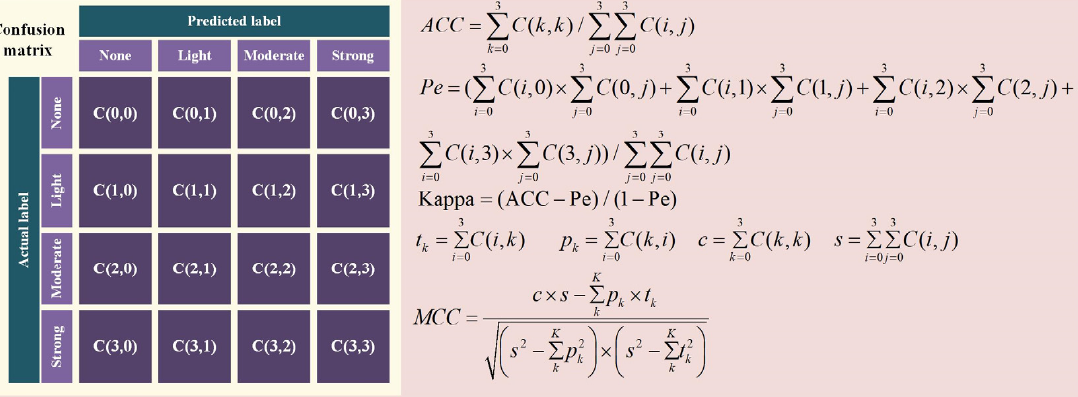
Figure 8. The fitness variation during the optimization process.